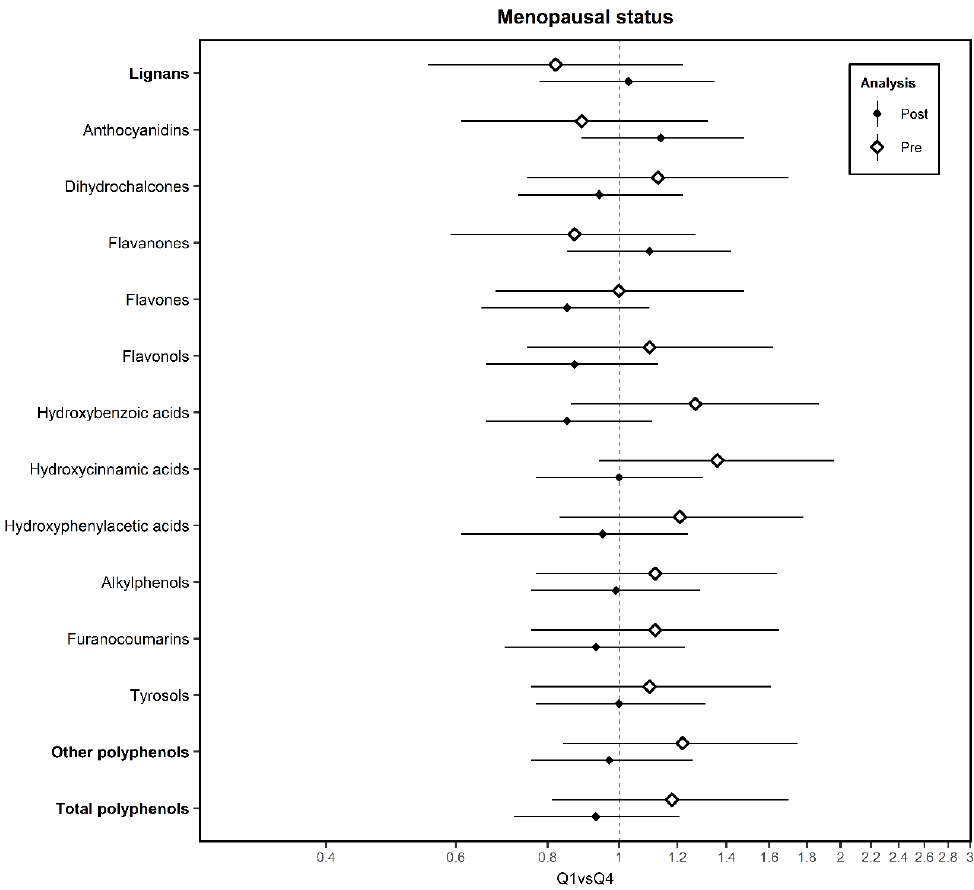
Figure 3. Association between estimated intake of subclasses of polyphenols with breast cancer by menopausal status, in the Multi-Case-Control (MCC)-Spain study. Post: Postmenopausal women; Pre: Premenopausal women. Adjusted ORs of Q4 vs. Q1 and 95% confidence intervals (CI) of BC by menopausal status according to polyphenol intake. ORs were adjusted for age, socioeconomic status, BC family history, body mass index, smoking, physical activity, energy, NSAIDs, age of menarche, number of children, past alcohol intake, hormone replacement therapy and oral contraceptives consumption as fixed e ff ects and province of residence as a random e ff ect